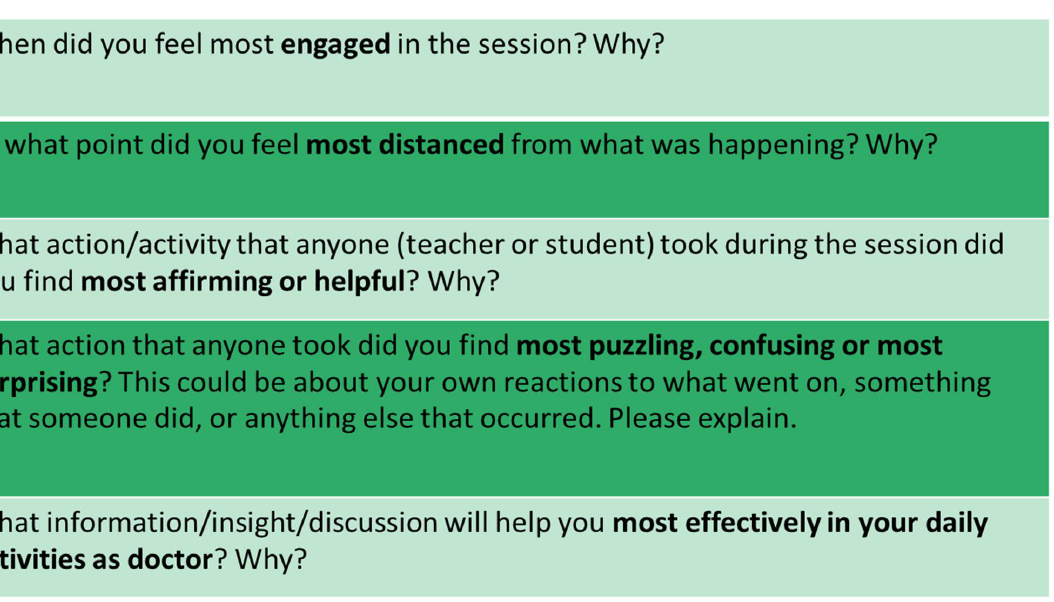
Figure 2. The CIQ completed by medical students after each SSC session, adapted from Brookfield [32].